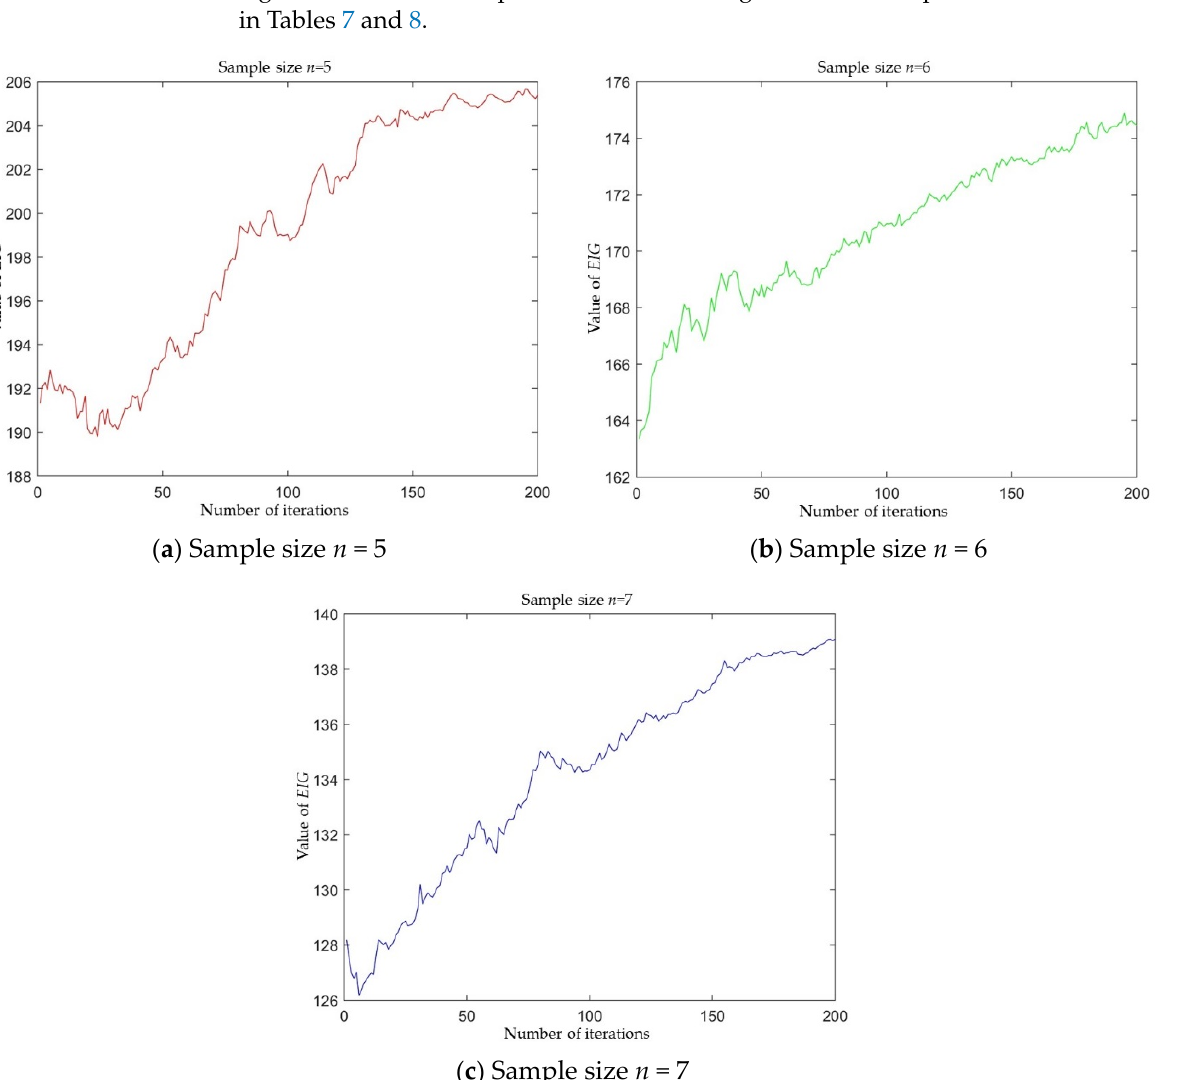
174.4615 Table 8. The optimal test plan of pre-test optimization( n = 7) n = 7 m